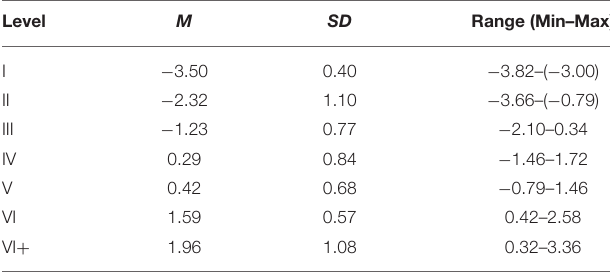
TABLE 4 | Descriptive statistics of item parameters of the LPA items per developmental level.